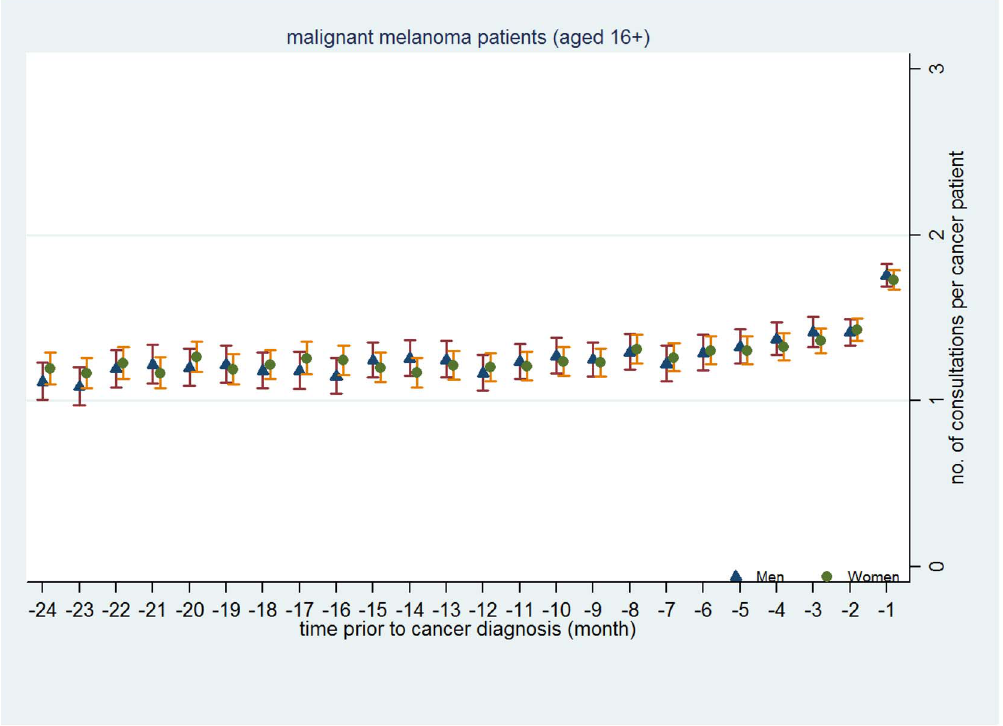
Figure 6. Mean number of primary care consultations per malignant melanoma patient made prior to cancer diagnosis by month and gender.